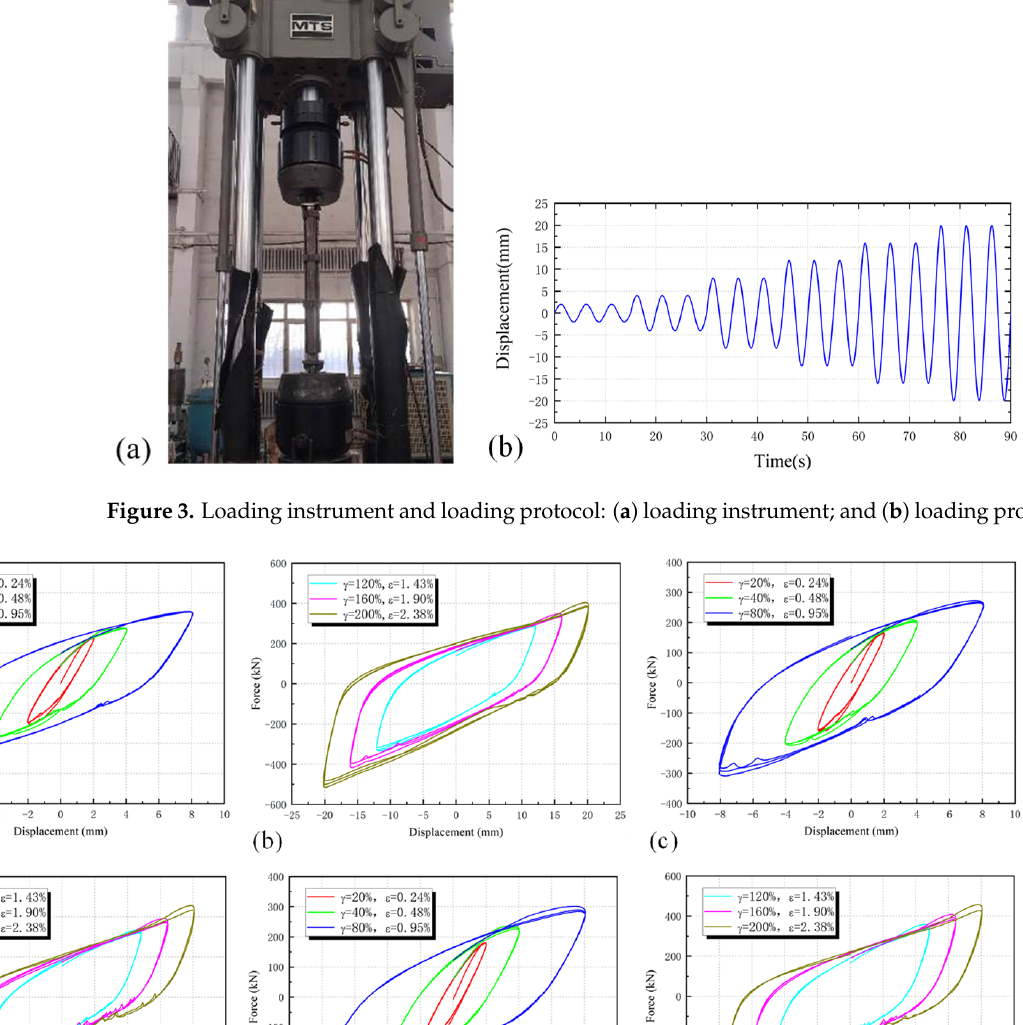
Figure 3. Loading instrument and loading protocol: ( a ) loading instrument; and ( b ) loading proto- cols.